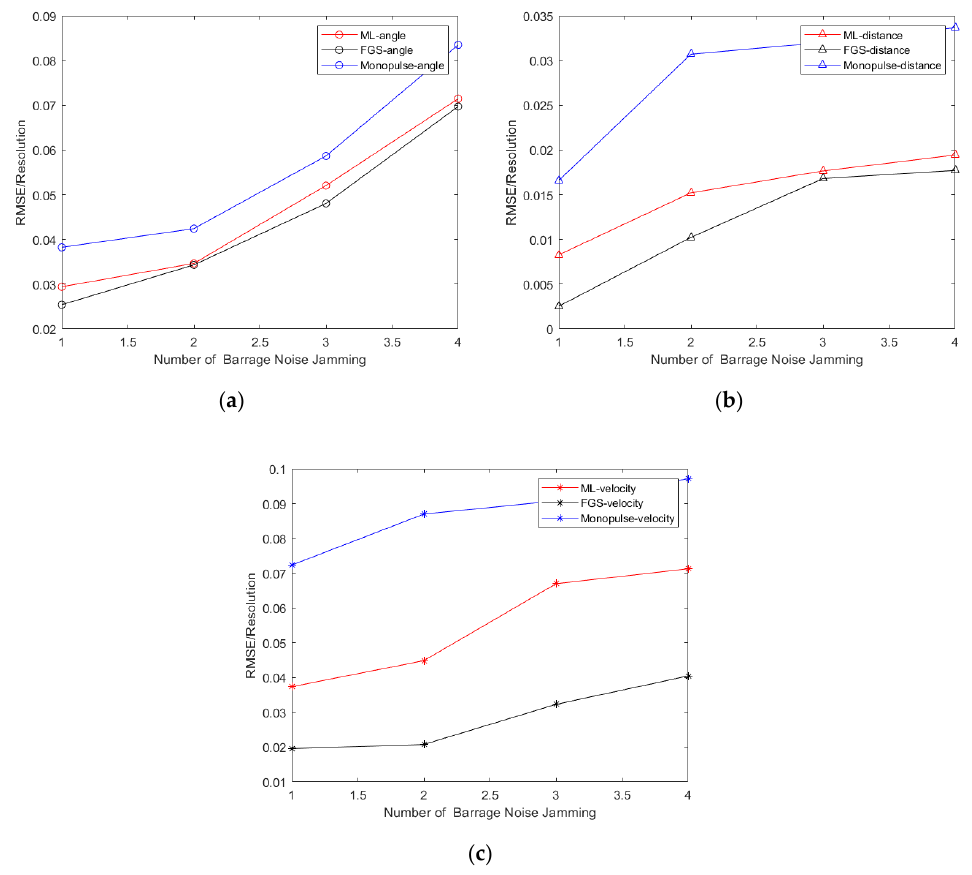
Figure 6. Statistical performance results with the number of barrage noise jamming increasing. ( a ) Angle estimation results; ( b ) Range estimation results; ( c ) Velocity estimation results.